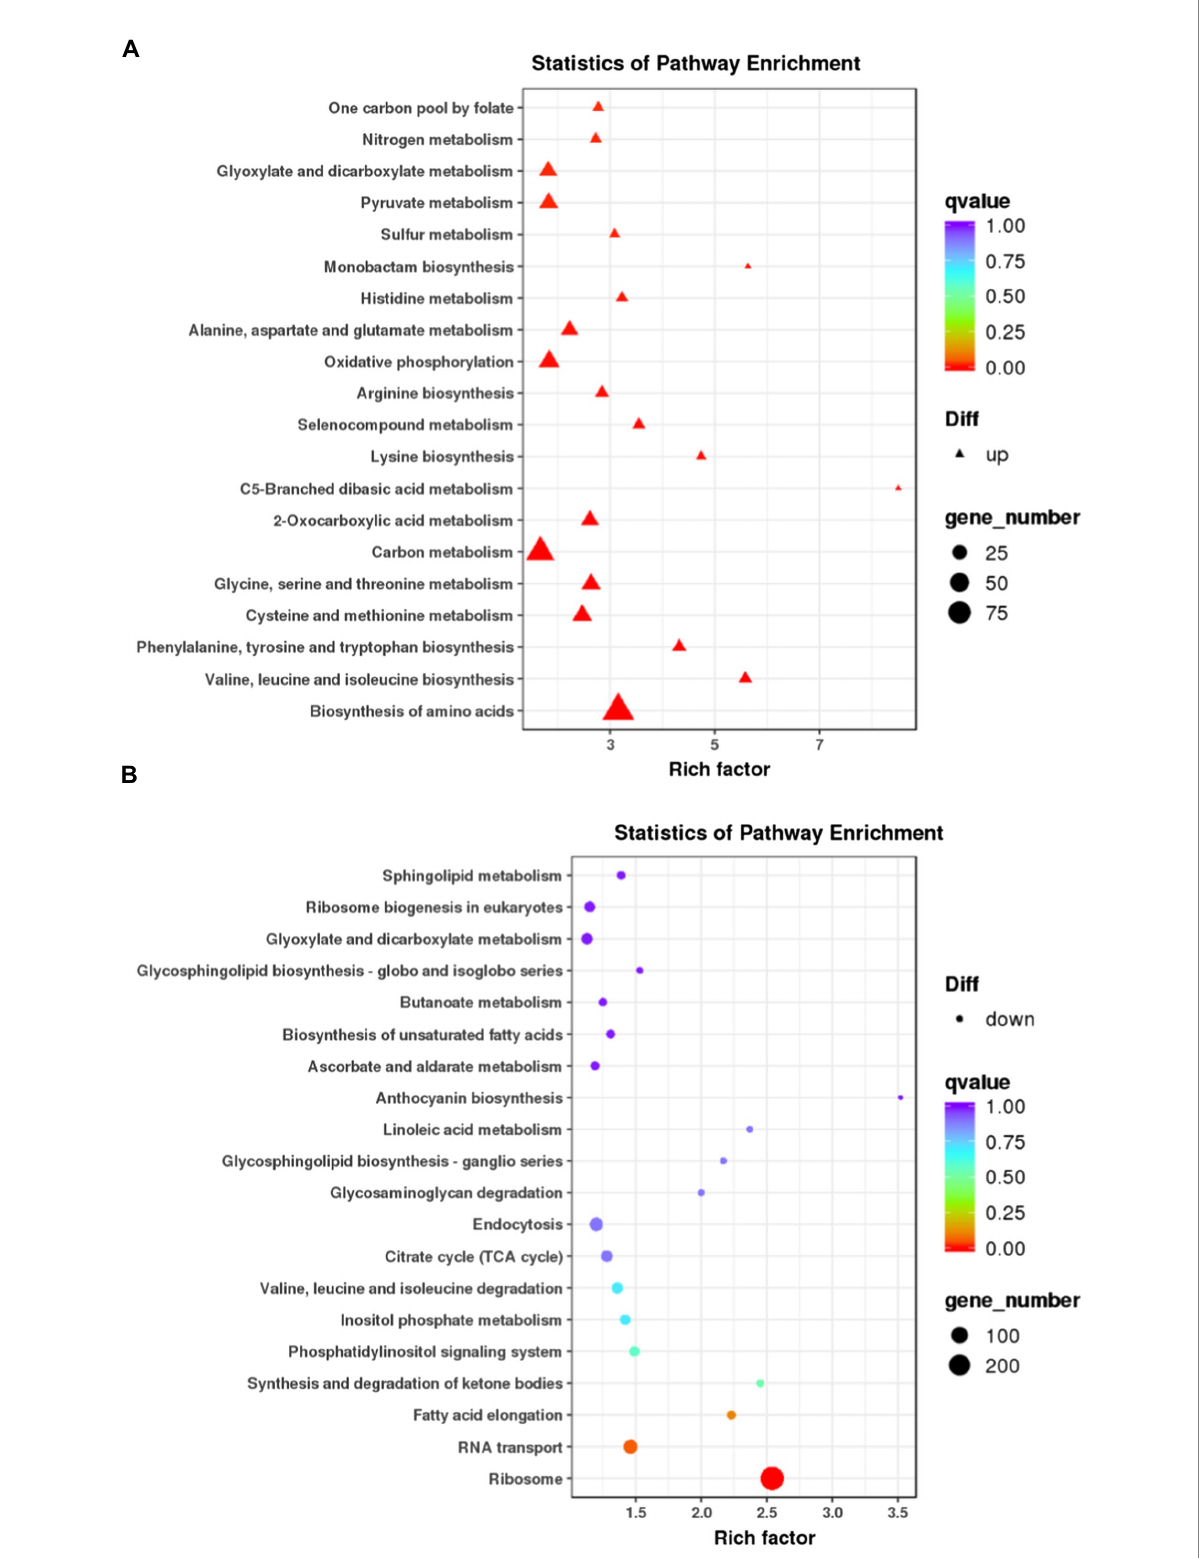
FIGURE 3 KEGG pathway enrichment analysis of DEGs. (A) KEGG of upregulated genes. (B) KEGG of downregulated genes. Each circle in the figure represents a KEGG pathway. The y -axis represents the pathway name and the x -axis represents Enrichment Factor, which represents the ratio of the proportion of genes annotated to a pathway in the differential genes to the proportion of genes annotated to this pathway in all